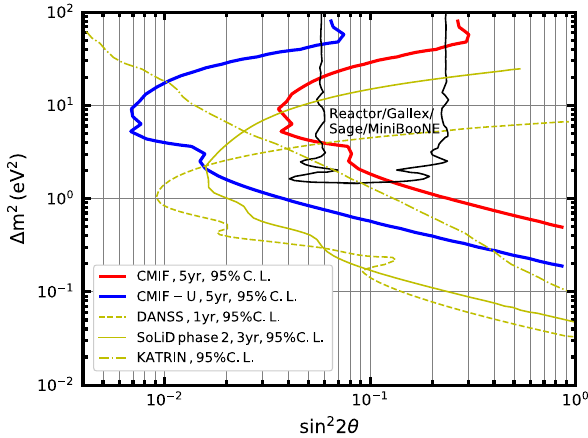
Fig. 7 TheexclusionlimitsthatcanbeobtainedwithCMIFandCMIF- U at 95% C.L.. The area inside of the black curve is the allowed region at 95% C.L. in the parameter space from the combination of reactor neutrino experiments, Gallex and Sage calibration sources experiments and MiniBooNE [16]. The 95% C.L. exclusion curves of the DANSS, SoLiD and the KATRIN [64,65,72,79] are also presented as the yellow